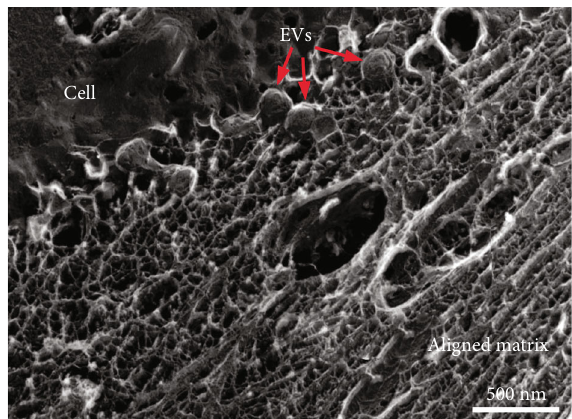
Figure 2: EVs ( red arrows ) budding from corneal fi broblasts ( cell ) in a self-assembled collagen matrix ( aligned matrix ). Image was modi fi ed and reproduced from Ren et al. 2008 [53] with permissions. Copyright (2008) Wiley-Liss,